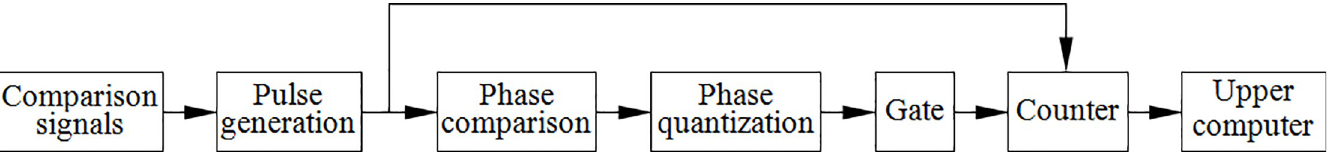
Fig 2. Frequency measurement scheme based on the group quantization phase